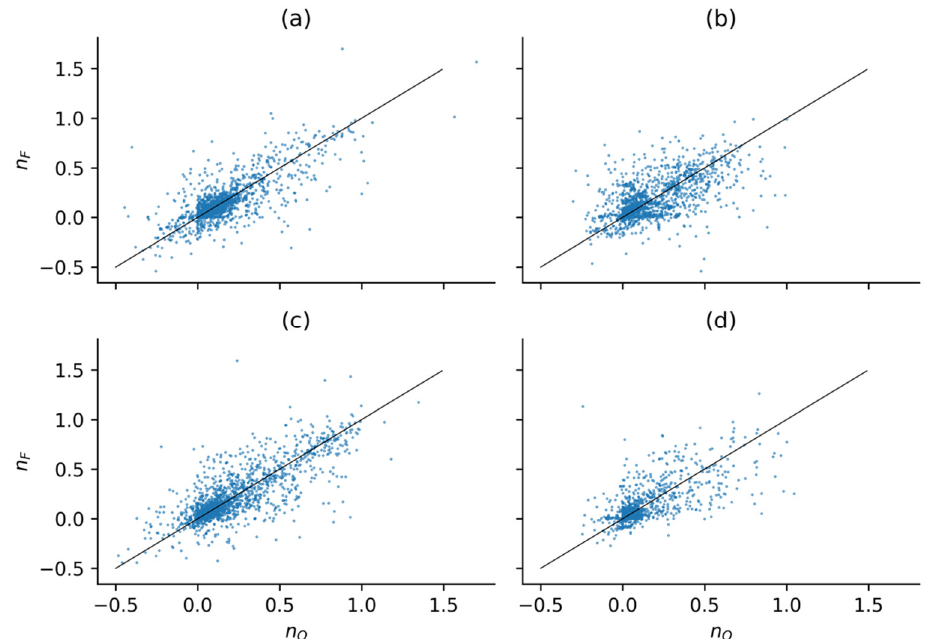
Figure 6. Forecasted cloud index at 5 min compared to observed in the benchmarking period for: ( a ) QLD-A; ( b ) QLD-B; ( c ) VIC-A; ( d ) QLD-C. The reference line y = x is shown in black.